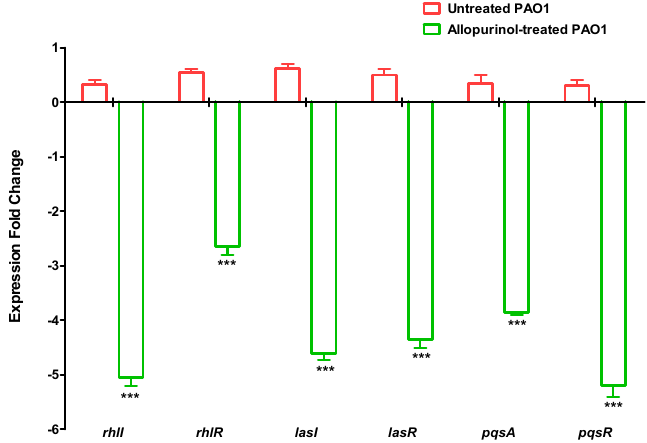
Figure 7. Allopurinol reduced the expressions of QS-encoding genes in P. aeruginosa . Allopurinol significantly reduced the expression of the genes that encode the three main QS systems in P. aeruginosa, namely, rhlI , rhlR , lasI , lasR , pqsA , and pqsR . *** Statistically significant difference.